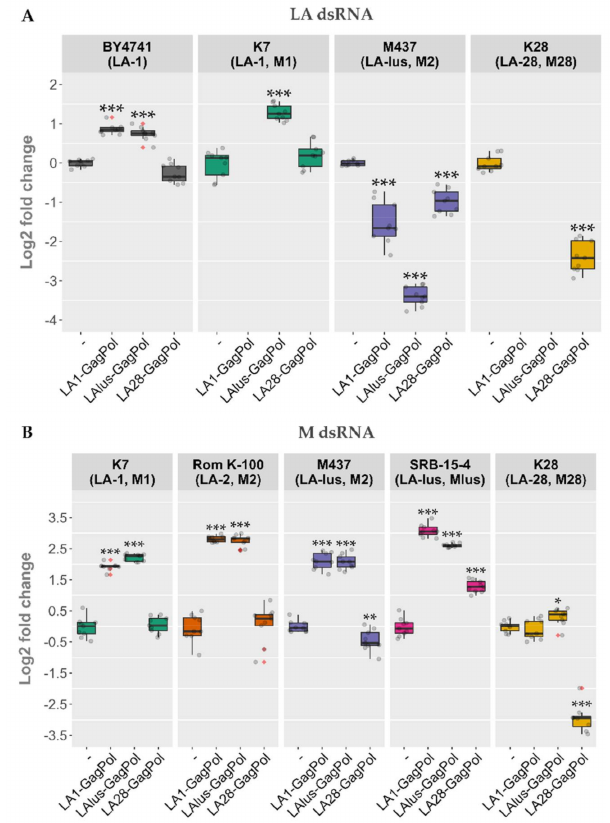
Figure 5. The impact of overexpression of LA-1, LA-lus, LA-28 capsid proteins on the maintenance of LA and M dsRNAs in BY4741, K7, Rom K-100, SRB-15-4, M437 and K28 strains. ( A ) Relative change in the amount of native LA virus dsRNA genome as compared to control samples (-). ( B ) Relative change in the amount of native M virus dsRNA genome as compared to control samples (-). Examined yeast strains are specified at the top, protein expression vectors used are listed below. Gray dots indicate individual samples, red dots denote outliers. Statistical significance was evaluated using Student’s t -test. p values below 0.05 were considered statistically significant (* p < 0.05, ** p < 0.01, *** p <